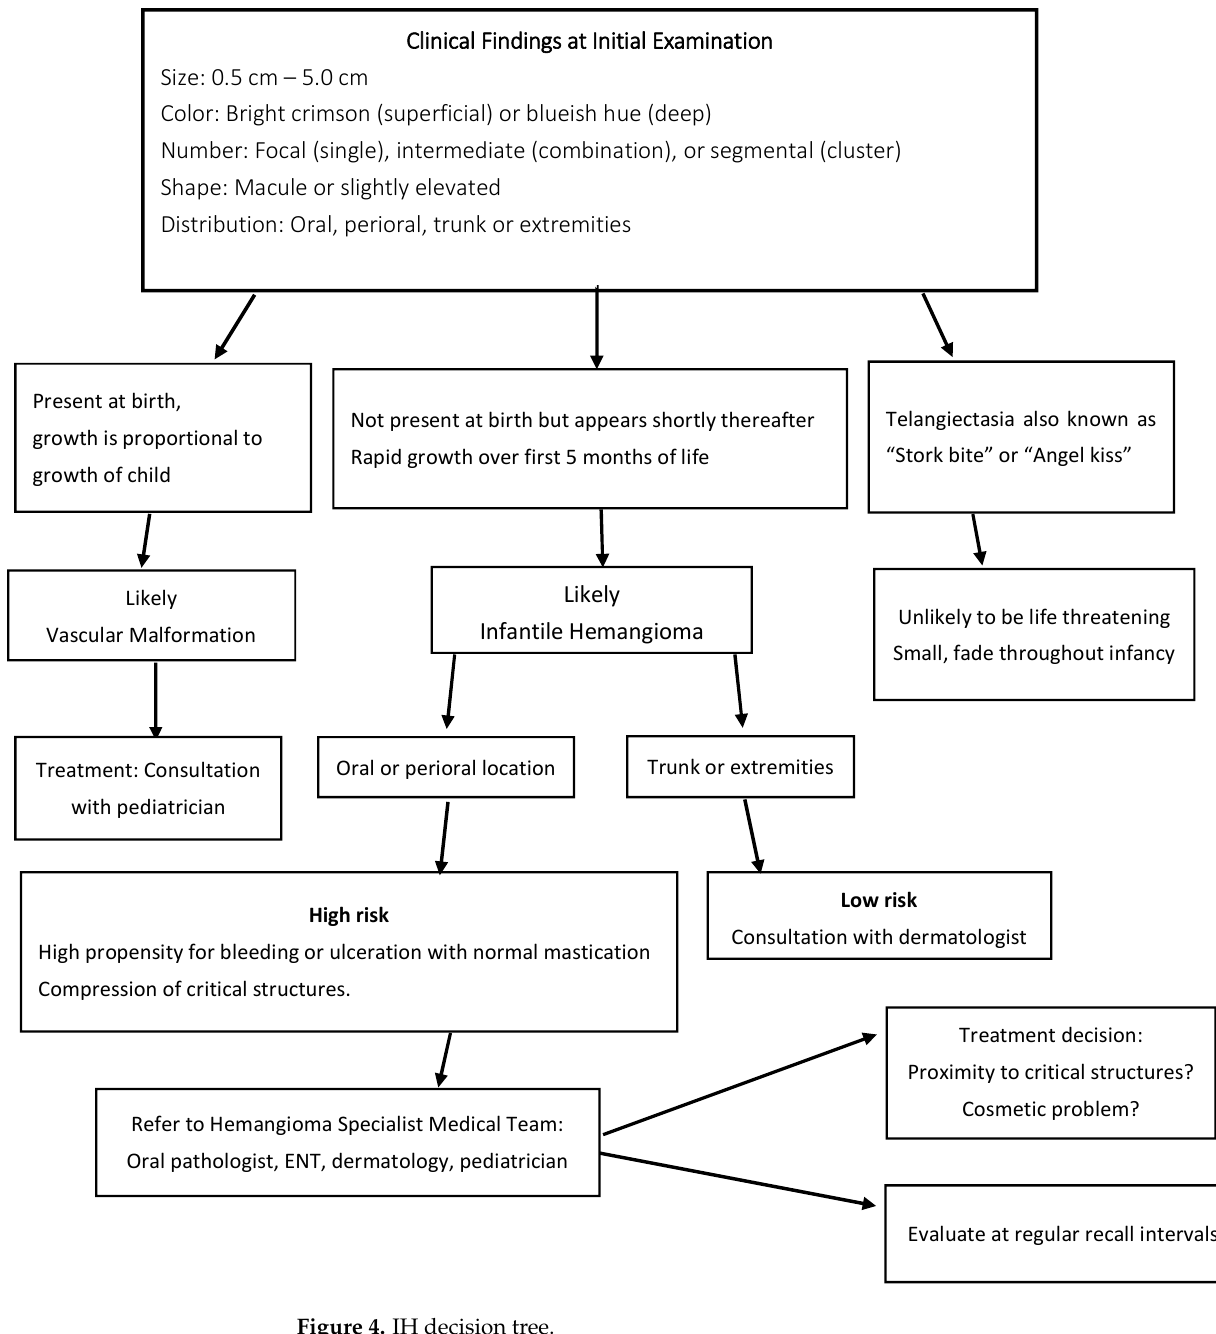
Figure 4. IH decision